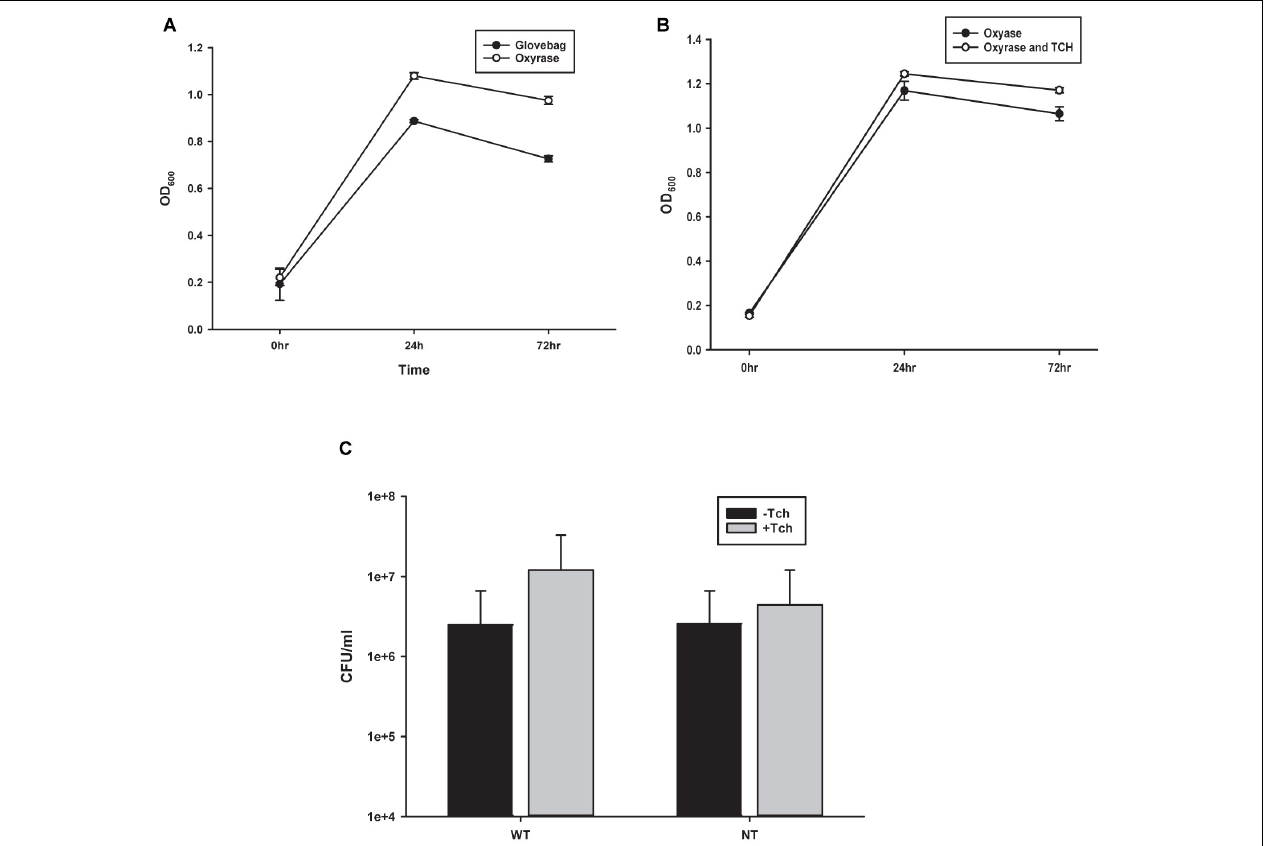
FIGURE 2 | Comparison of growth techniques. (A) Growth curves from observing OD 600 of Costridium novyi under glovebag conditions vs. with oxyrase enzyme. No statistical difference was found at any time point as determined by a Student’s standard t -test ( n = 3 samples per time point). (B) Growth curves from observing OD 600 of Costridium novyi under in oxyrase vs. oxyrase with the addition of taurocholate. No statistical difference was found at any time point as determined by a Student’s standard t -test ( n = 3 samples per time point). (C) Spore enumeration of Clostridium novyi wild type and non-toxic strains with and without the addition of taurocholate. No statistical difference was found at any time point as determined by a Holms-Sidak test ( n = 3 samples per